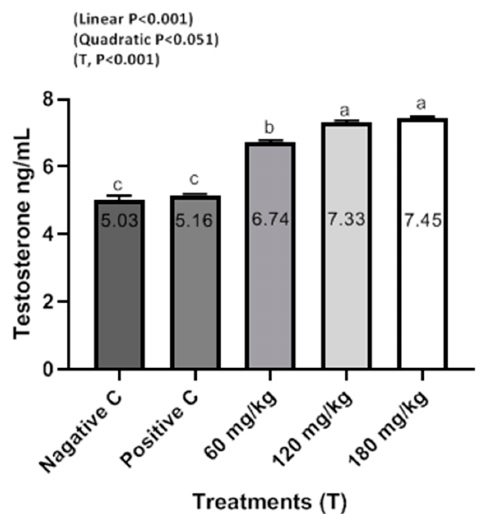
Figure 1. Testosterone ng / mL of male rabbits in response to dietary treatments including a basal diet (NC), a basal diet supplemented with a 500 mg / kg oxytetracycline antibiotic (PC), and a basal diet supplemented with 60, 120, or 180 mg / kg of TEO at 130 days of age. a–c Means within a row with di ff erent superscripts di ff er significantly at p < 0.05.